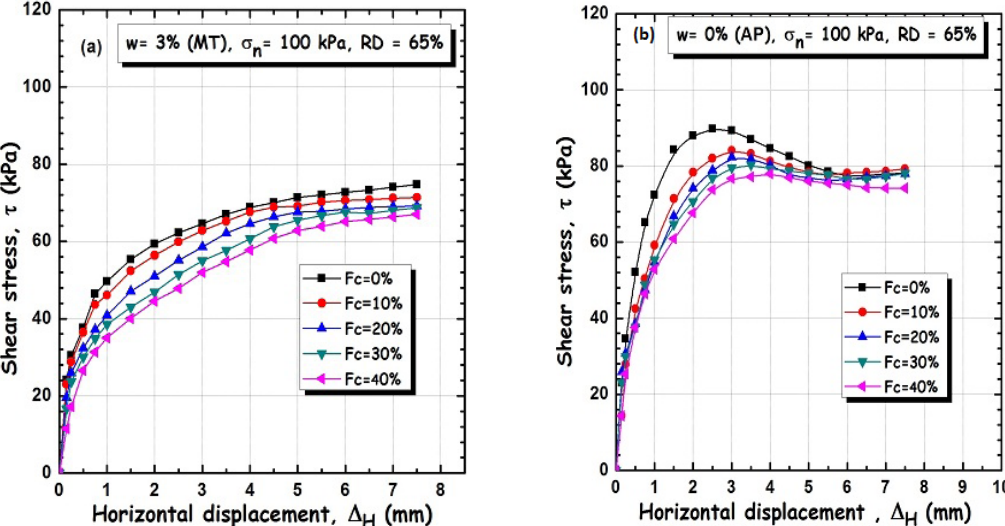
= 100 kPa): (a) variation of the shear n